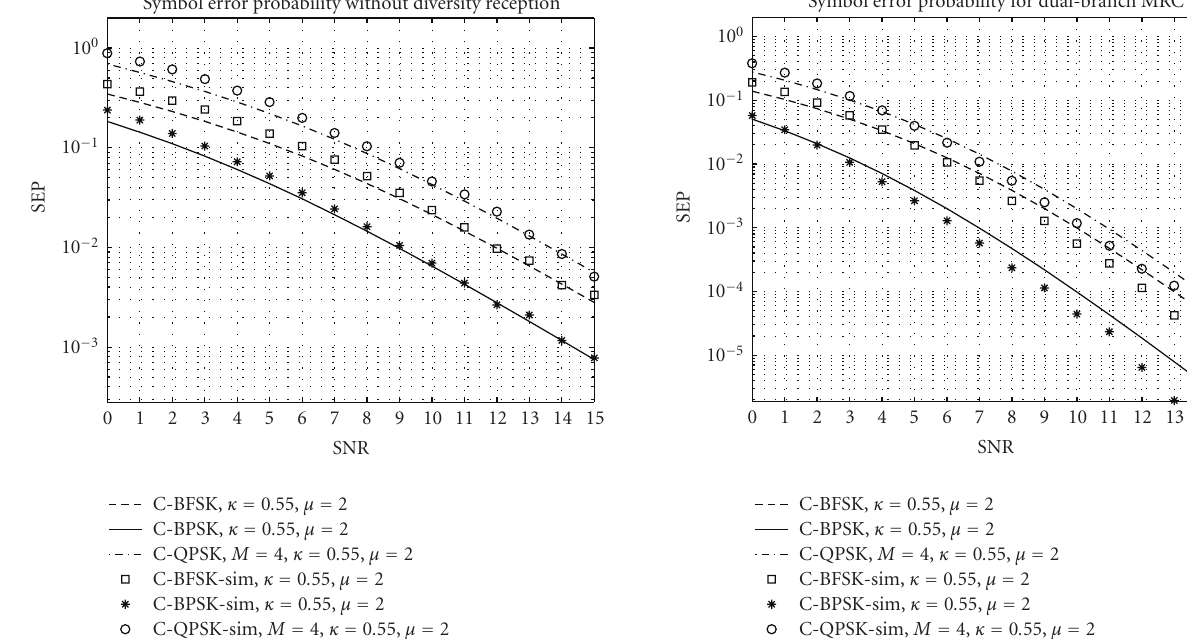
Figure 11: BEP/SEP for coherent detection, no diversity. Figure 12: BEP/SEP for coherent detection, dual-branch